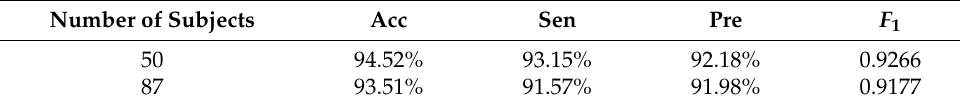
Table 9. Comparison of identification results for 50 and 87 subjects.